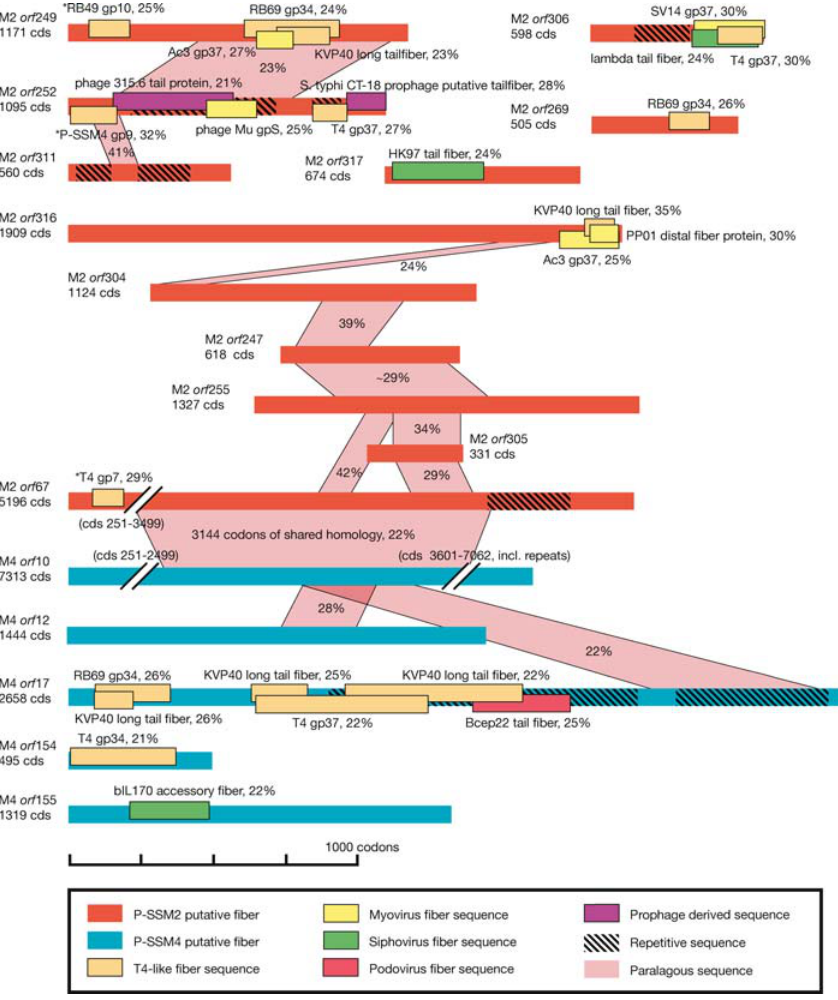
Figure 6. Bioinformatically Identified Tail Fiber Genes from Prochlorococcus Myoviruses Red bars indicate P-SSM2 ORFs (labeled as M2); blue bars indicate P-SSM4 ORFs (labeled as M4). Due to space constraints, P-SSM2 orf67 and P- SSM4 orf10 are broken as indicated. DOI: